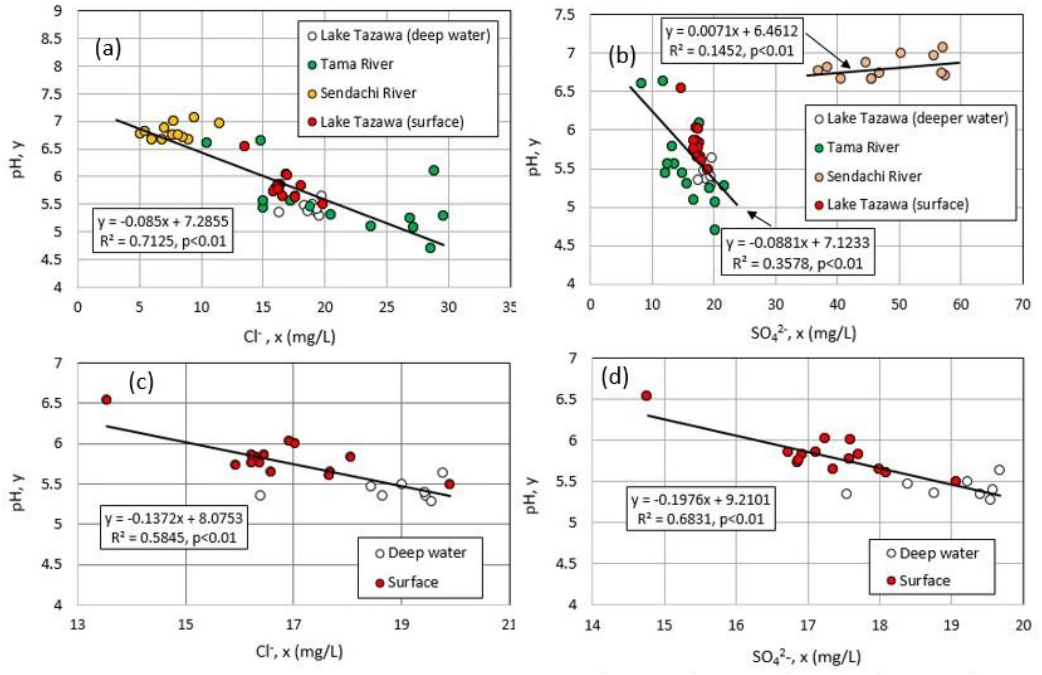
Figure 4. Relations between Cl − or SO 4 2 − concentration and pH for ( a ) and ( b ) (all the samples) and for ( c ) and ( d ) (lake water).